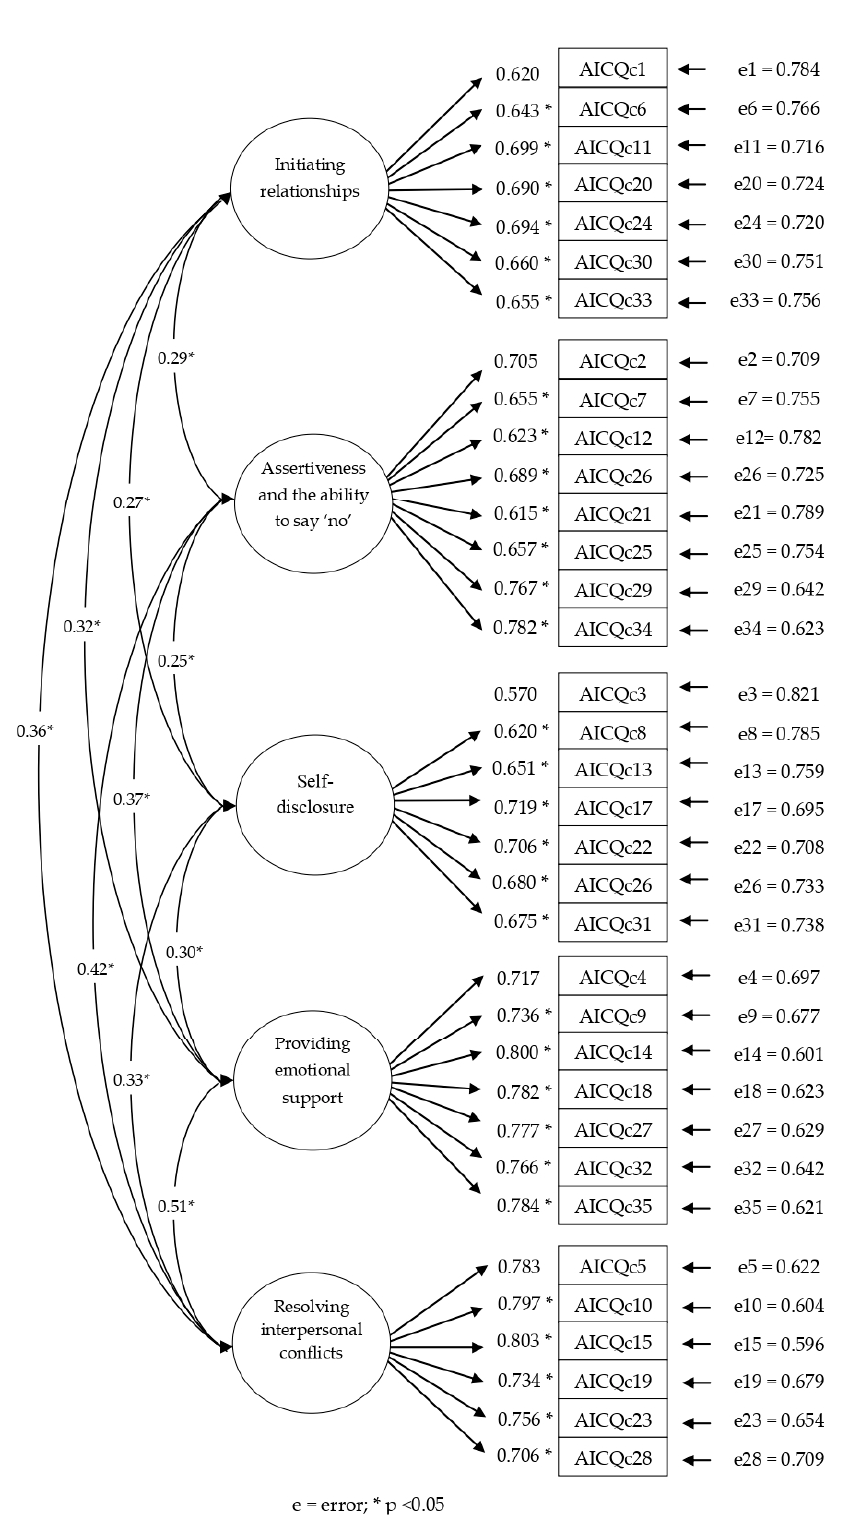
Figure 1. Standardized solutions for the Confirmatory Factor Analysis.